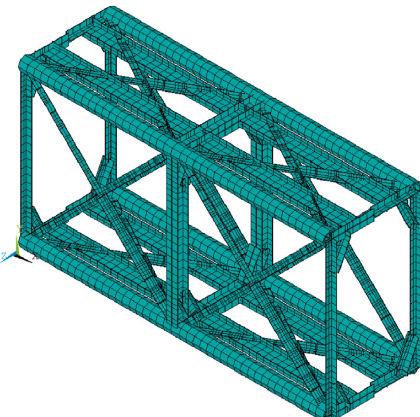
Figure 6: FEM of midspan arch rib—stiff skeleton